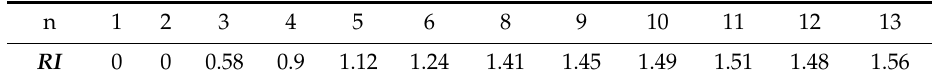
Table 2. Random Index (RI)